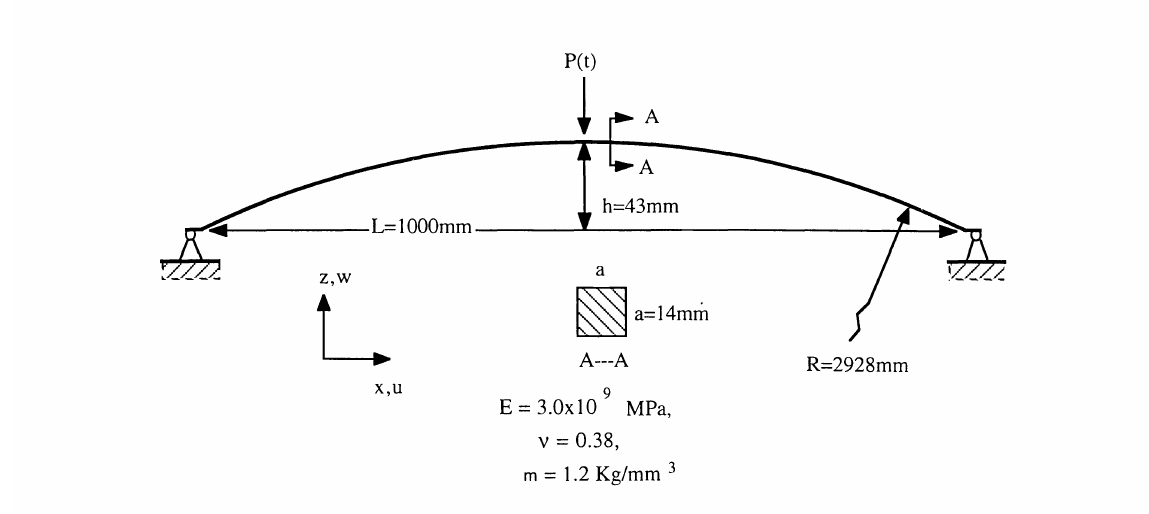
FIGURE 6 Geometry of the shallow arch with fixed